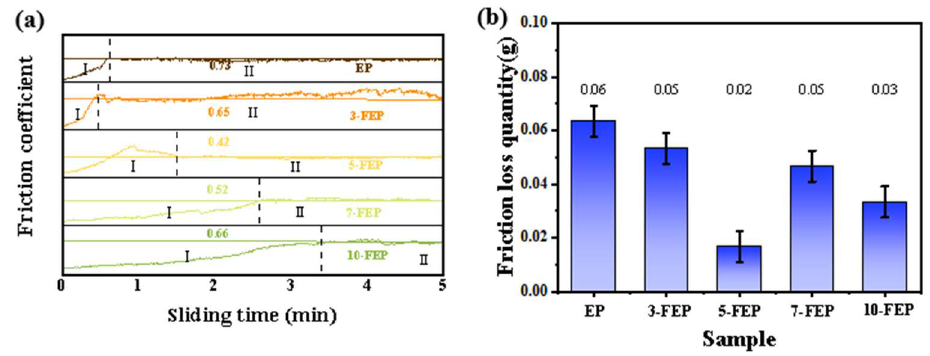
Figure 7. ( a ) Friction coefficient of the composite coating; ( b ) Friction loss of composite coatings.